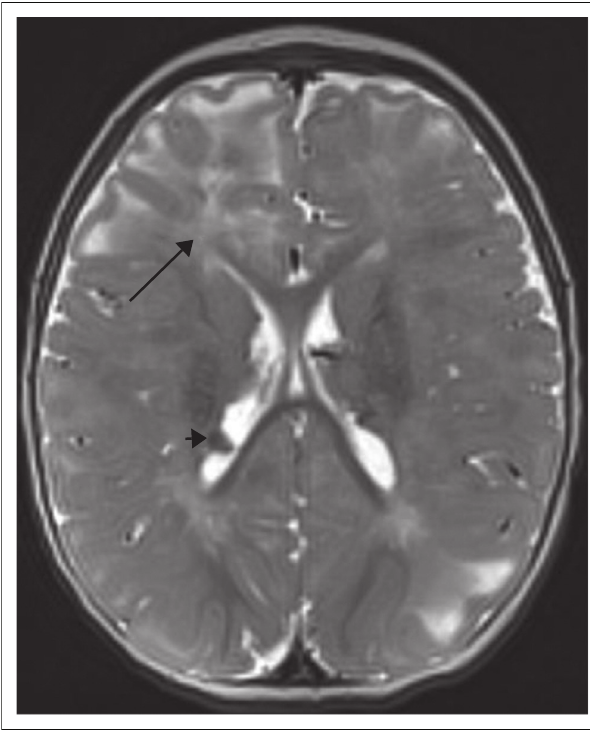
FIGURE 6: Axial T2W demonstrates multiple tubers and white matter lesions. Note how the subcortical tuber is associated with linear white matter high signal that tracks towards the ventricle (arrow). Also note the hypointense subependymal nodule